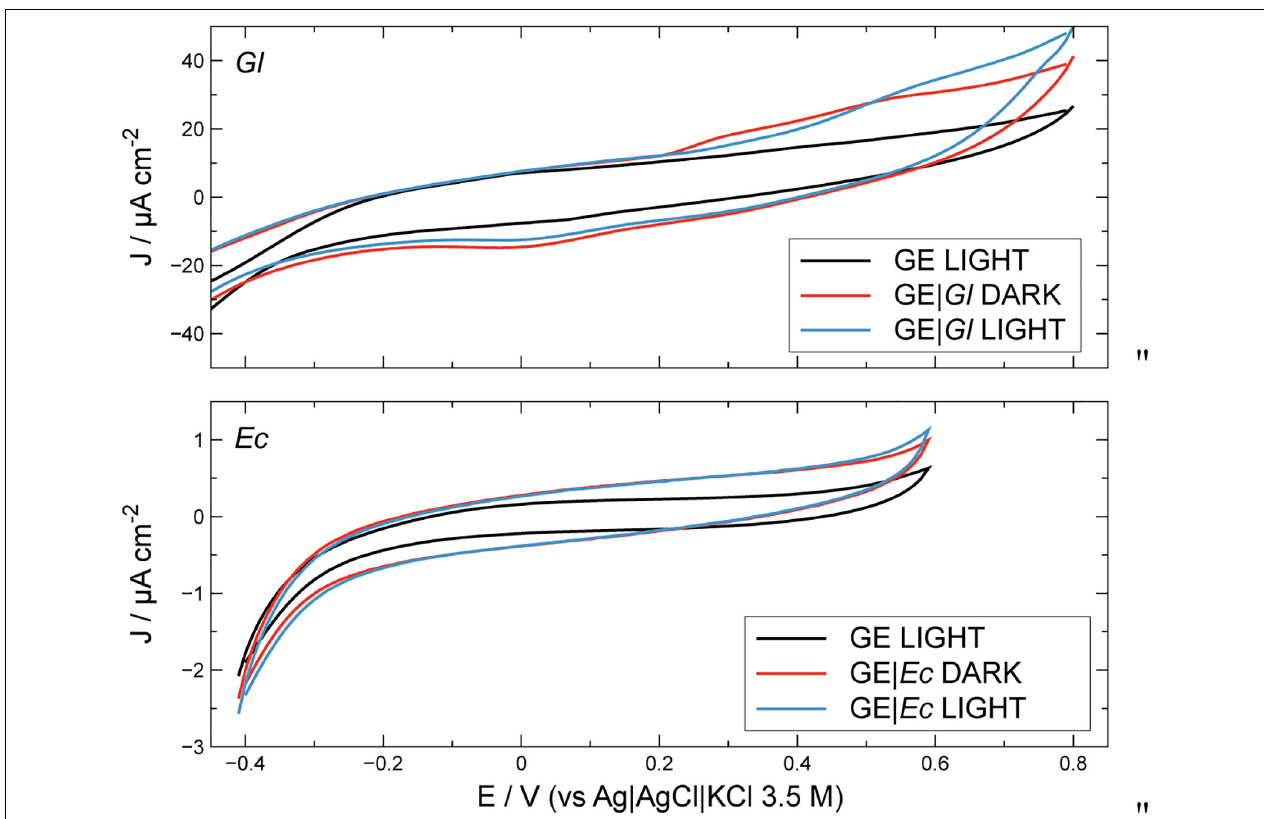
FIGURE 2 | Cyclic voltammetry profiles for unmodified and modified electrodes, in the presence and in the absence of light. Conditions: PBS 0.1 M at pH 7.0. Scan rate: 10 mV s − 1 . GE, graphite electrode; Gl, Gloeocapsopsis sp. modification; Ec, Escherichia coli modification.